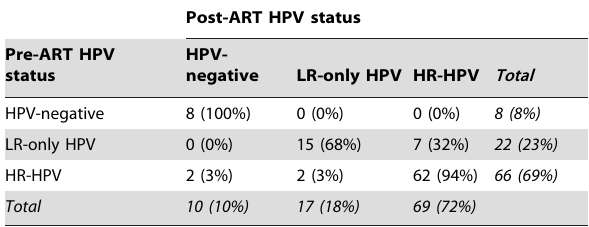
Table 2. Cross-classification of cumulative HPV infection status in the 6 months before compared to after ART